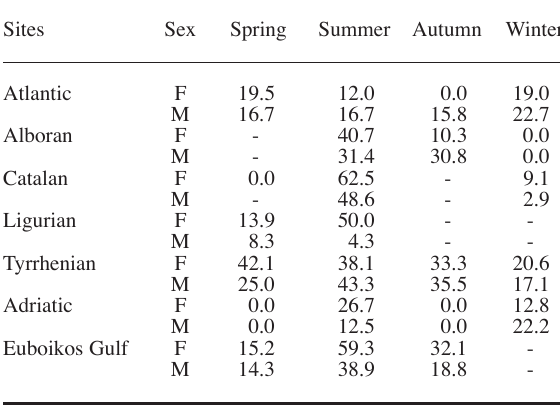
Sites Sex Spring